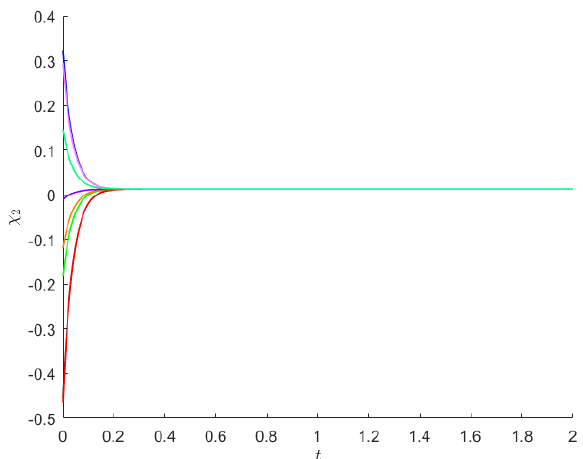
Figure 2. For Example 1, from 8 initial values (each shown using a separate color), are depicted the trajectories of state χ 2